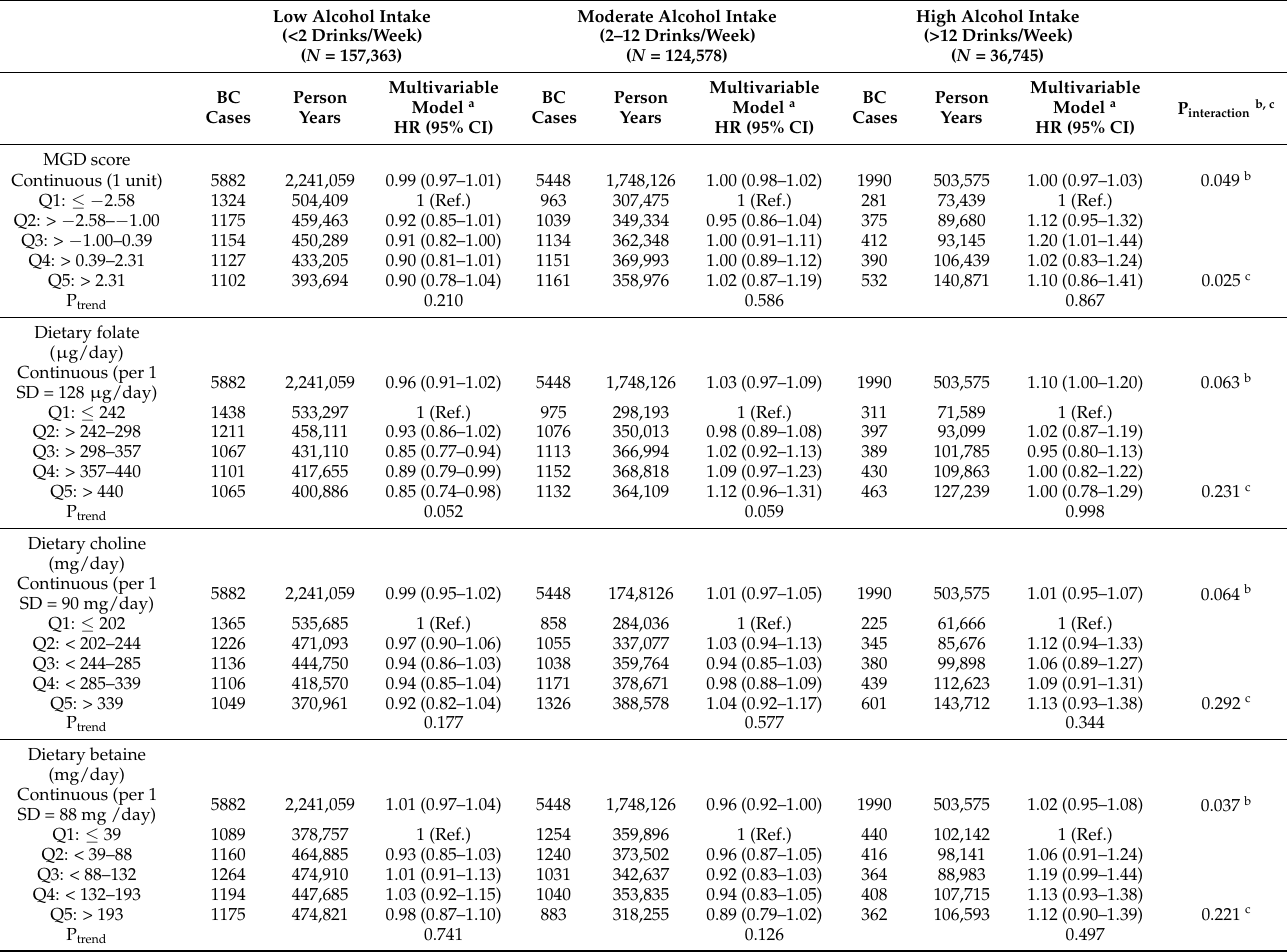
Table 3. Hazard ratios (HRs) and 95% confidence intervals (CIs) for breast cancer (BC) by daily dietary intake of methyl- group donors (MGDs) by levels of alcohol intake in 318,686 women in the EPIC